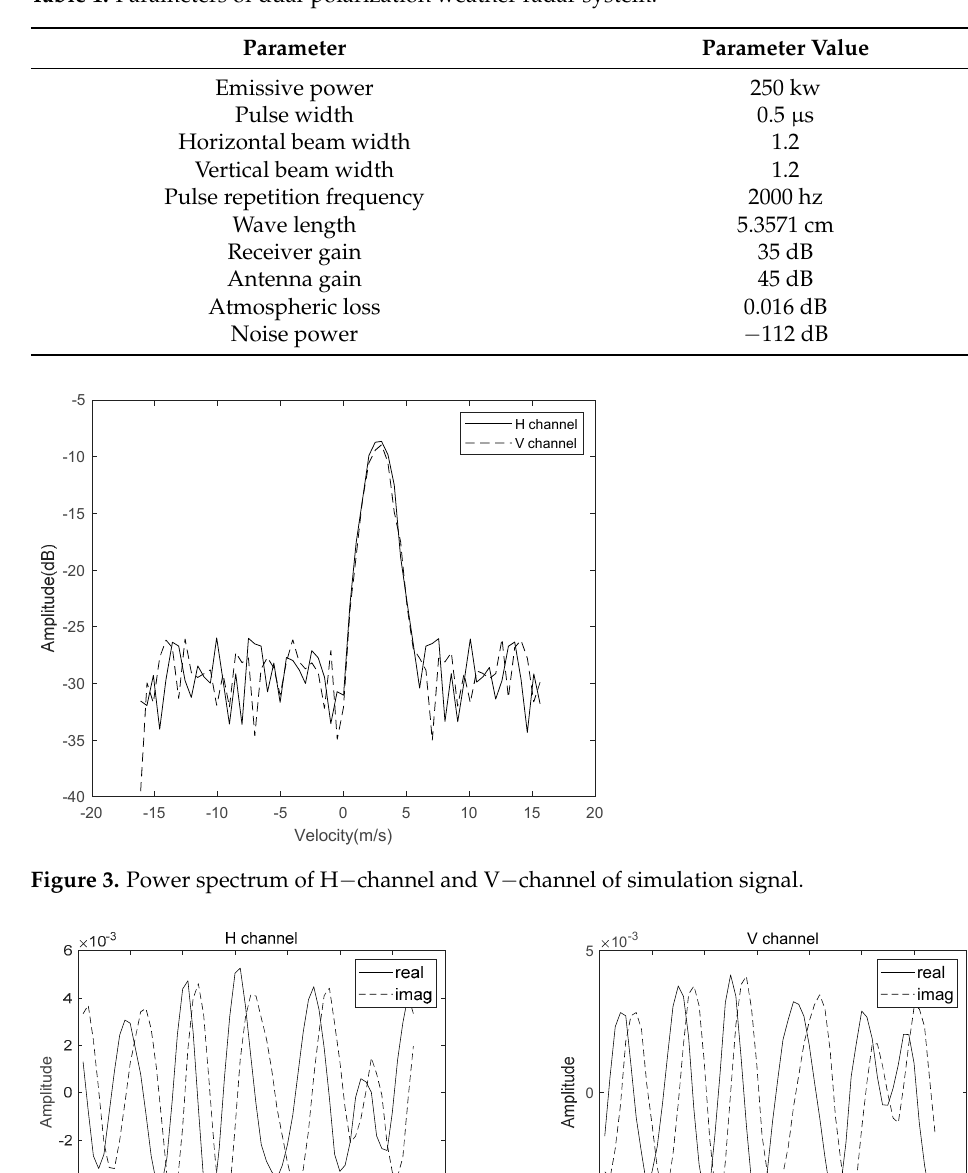
Table 1. Parameters of dual-polarization weather radar system.